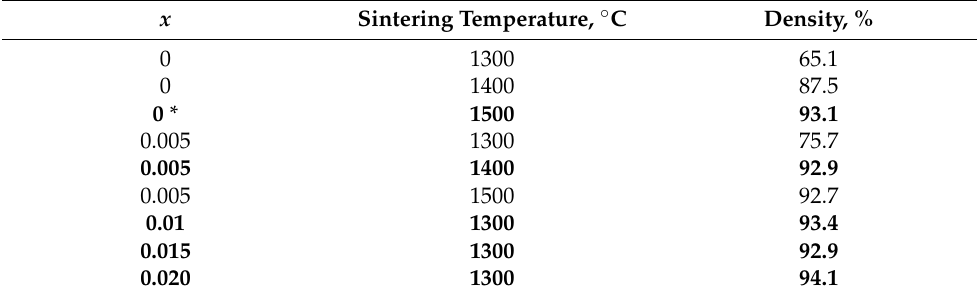
Table 2. Relative density of La 0.5 − x Sr 0.5 FeO 3 − δ ceramics.